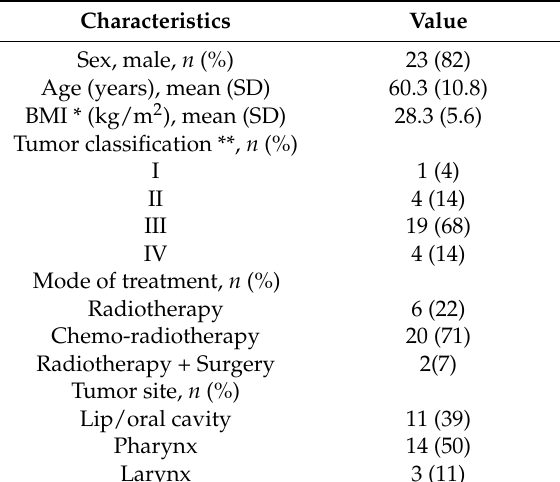
Table 1. Baseline characteristics of patients ( n =